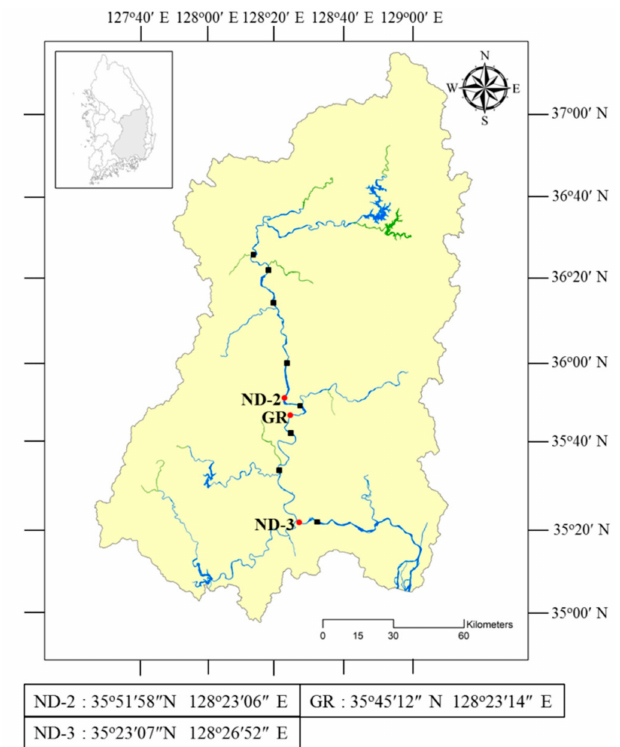
Figure 1. Map of the Nakdong River basin area. Red circles indicate the sampling stations and black squares indicate the weirs in the Nakdong